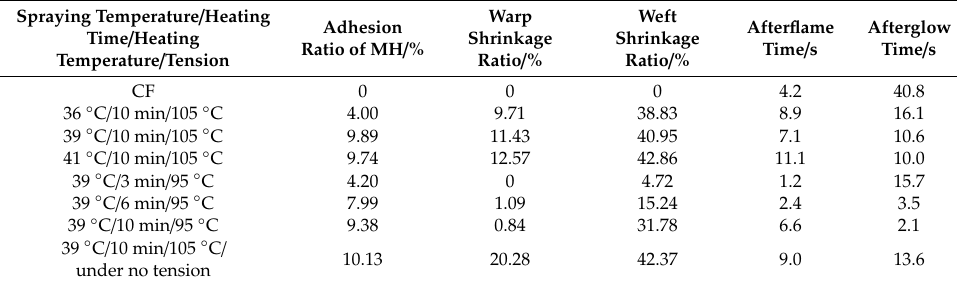
Table 1. The data of flame retardancy of CF / MH under di ff erent adhesion